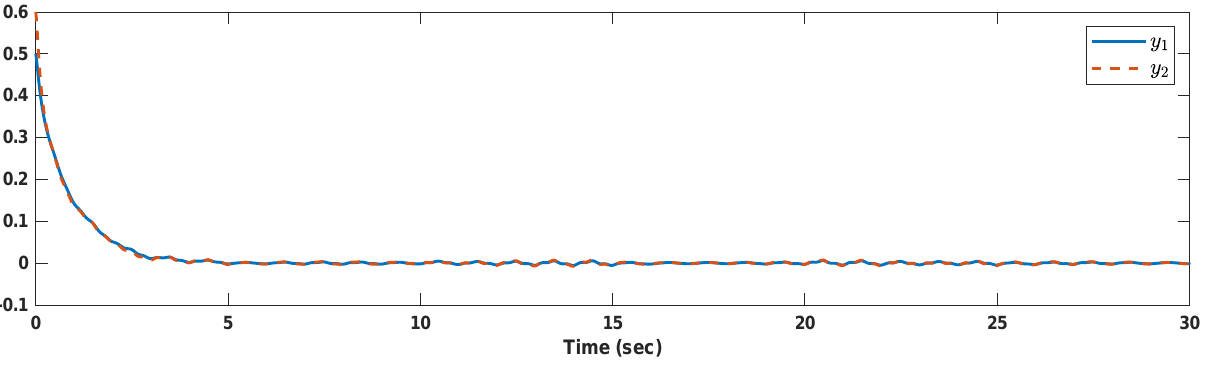
Figure 11. Example 2: Time response of output.